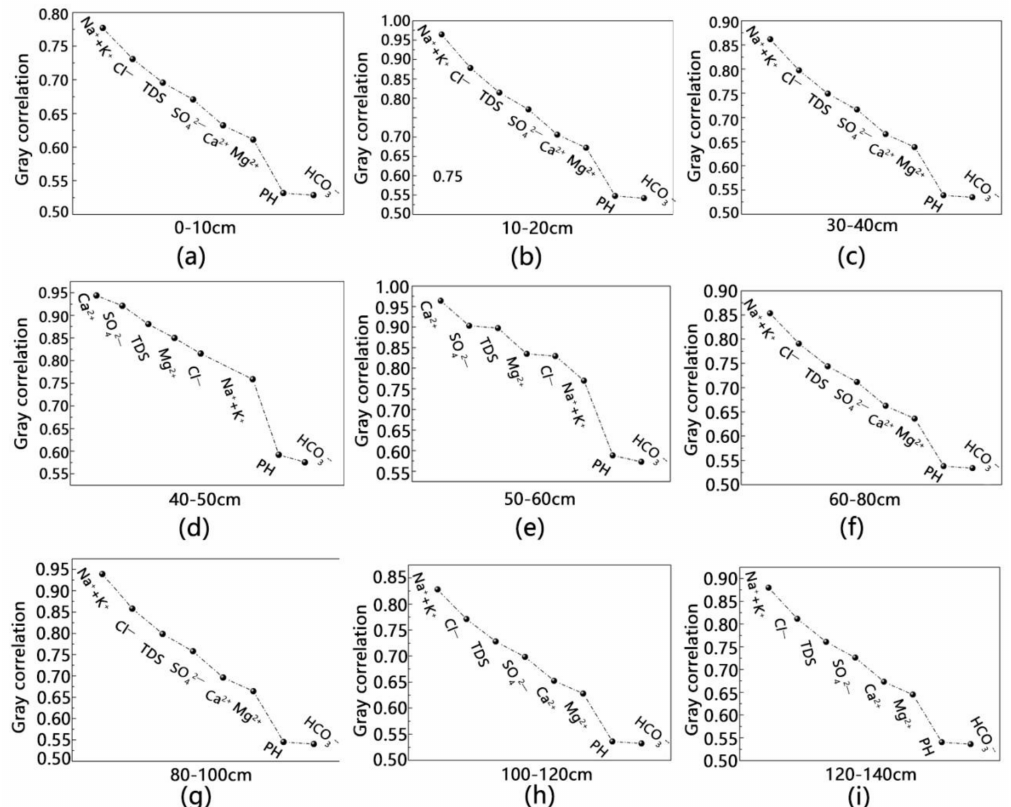
Figure 13. Gray correlation between soil salinity content at different depths and